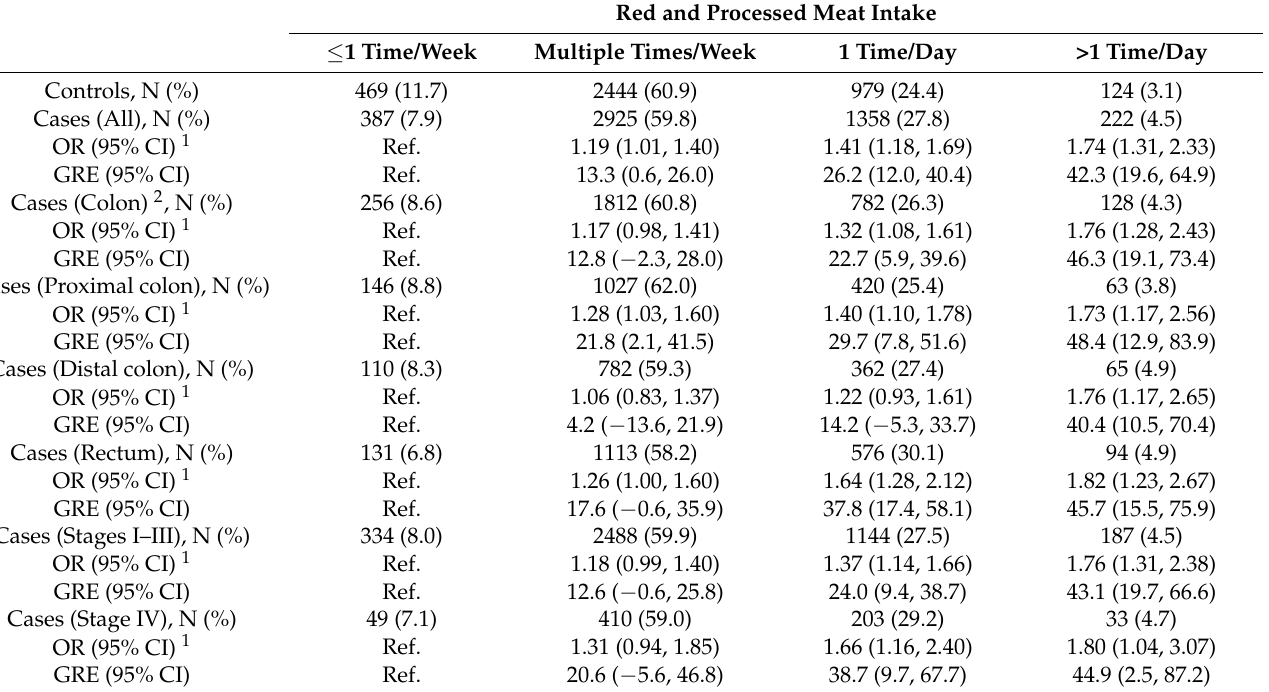
Table 5. Genetic risk equivalents for comparisons between red and processed meat intake categories for colorectal cancer